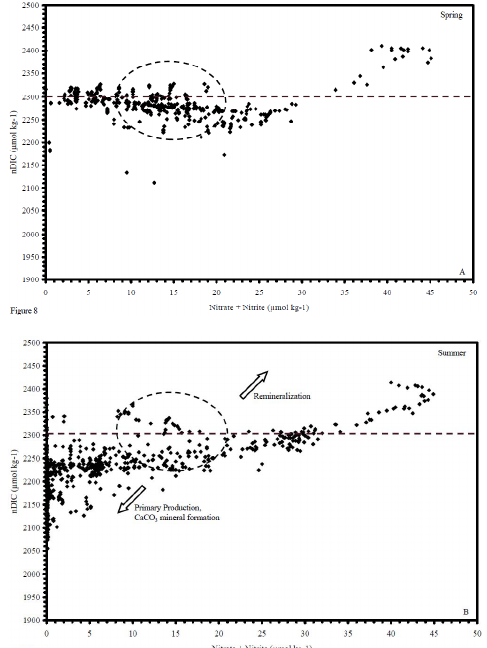
Fig. 8. Spring and summer concentrations of nDIC (µmoleskg − 1 ) relative to nitrate+nitrite (µmoleskg − 1 ) . (A) Spring. For nearly all concentrations of nitrate+nitrite, nDIC ranged from ∼ 2225µmoleskg − 1 to 2350µmoleskg − 1 . Average spring concen- tration (2300µmoleskg − 1 ) is marked by the dotted line. (B) Sum- mer. nDIC concentrations decreased with respect to nitrate, rang- ing from ∼ 2050µmoleskg − 1 to 2350µmoleskg − 1 . The springtime average (2300µmoleskg − 1 ) is also plotted here, showing that most summertime points fall below the springtime average due to primary production and carbonate mineral